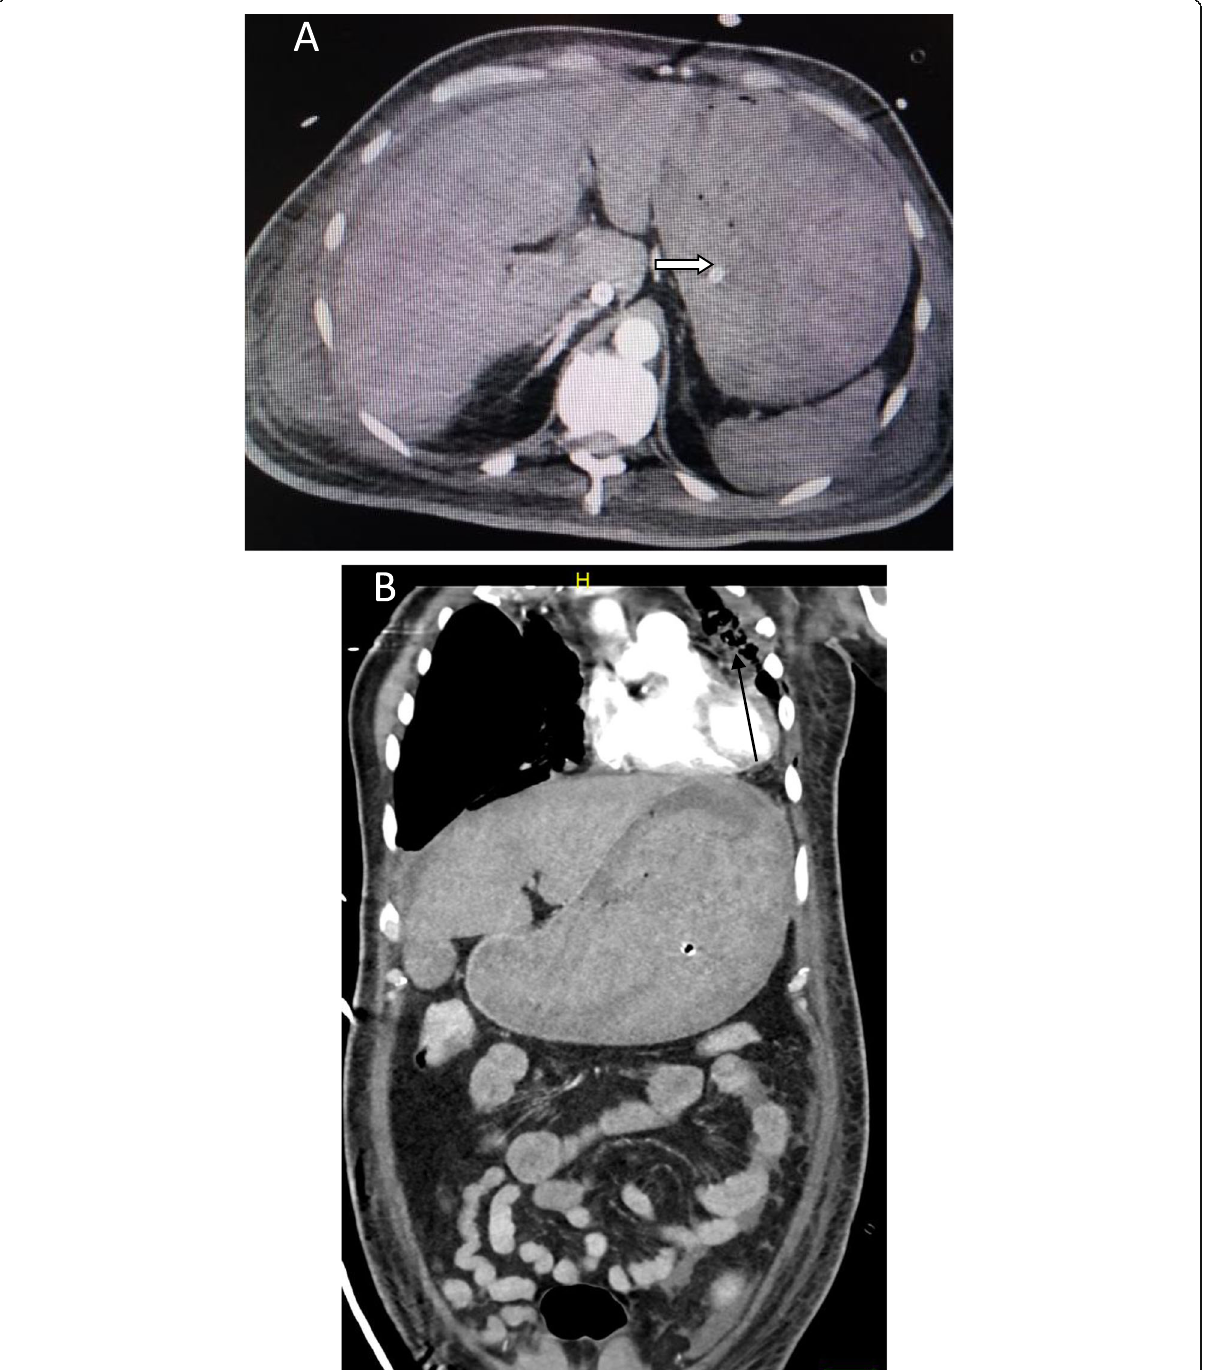
Fig. 5 Fifty-six-year-old confirmed COVID-19 male patient admitted to the ICU presented with two attacks of acute hematemesis. a Axial CT of the abdomen and b coronal reconstruction done. The stomach is loaded with blood clots yet no signs of active contrast extravasation in the arterial phase of the study; the nasogastric tube is seen in place (open arrow in a ); there are parenchymal lung changes in COVID-19 noted in the left lung field (arrow in b